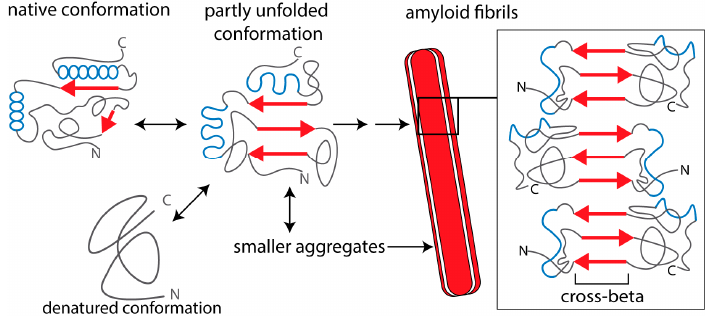
Figure 1. Schematic representation of amyloid protein aggregation. The β -strands in the amyloid-forming protein are indicated as red arrows and α -helices as blue spheres. In the native conformation, β -strands of the monomeric protein (if present) are not aligned and “shielded”, which prevents intermolecular aggregation. A partially unfolded or misfolded molecule can form different kinds of intermolecular aggregates. Amyloid oligomers are relatively small, compact structures that may be composed of antiparallel β -strands or contain α -helical conformations. Protofibrils and mature amyloid fibrils are formed via β -strand stacking, forming extended networks of β -sheets with a characteristic cross-beta structure. Mature fibrils consist of a few identical fibrillar “subunits”. Smaller aggregates (oligomers and protofibrils) are mostly cytotoxic, whereas extracellular, fibrillar amyloid deposits can also impair tissue and organ function by impairing blood supply to the cells (see text for references).